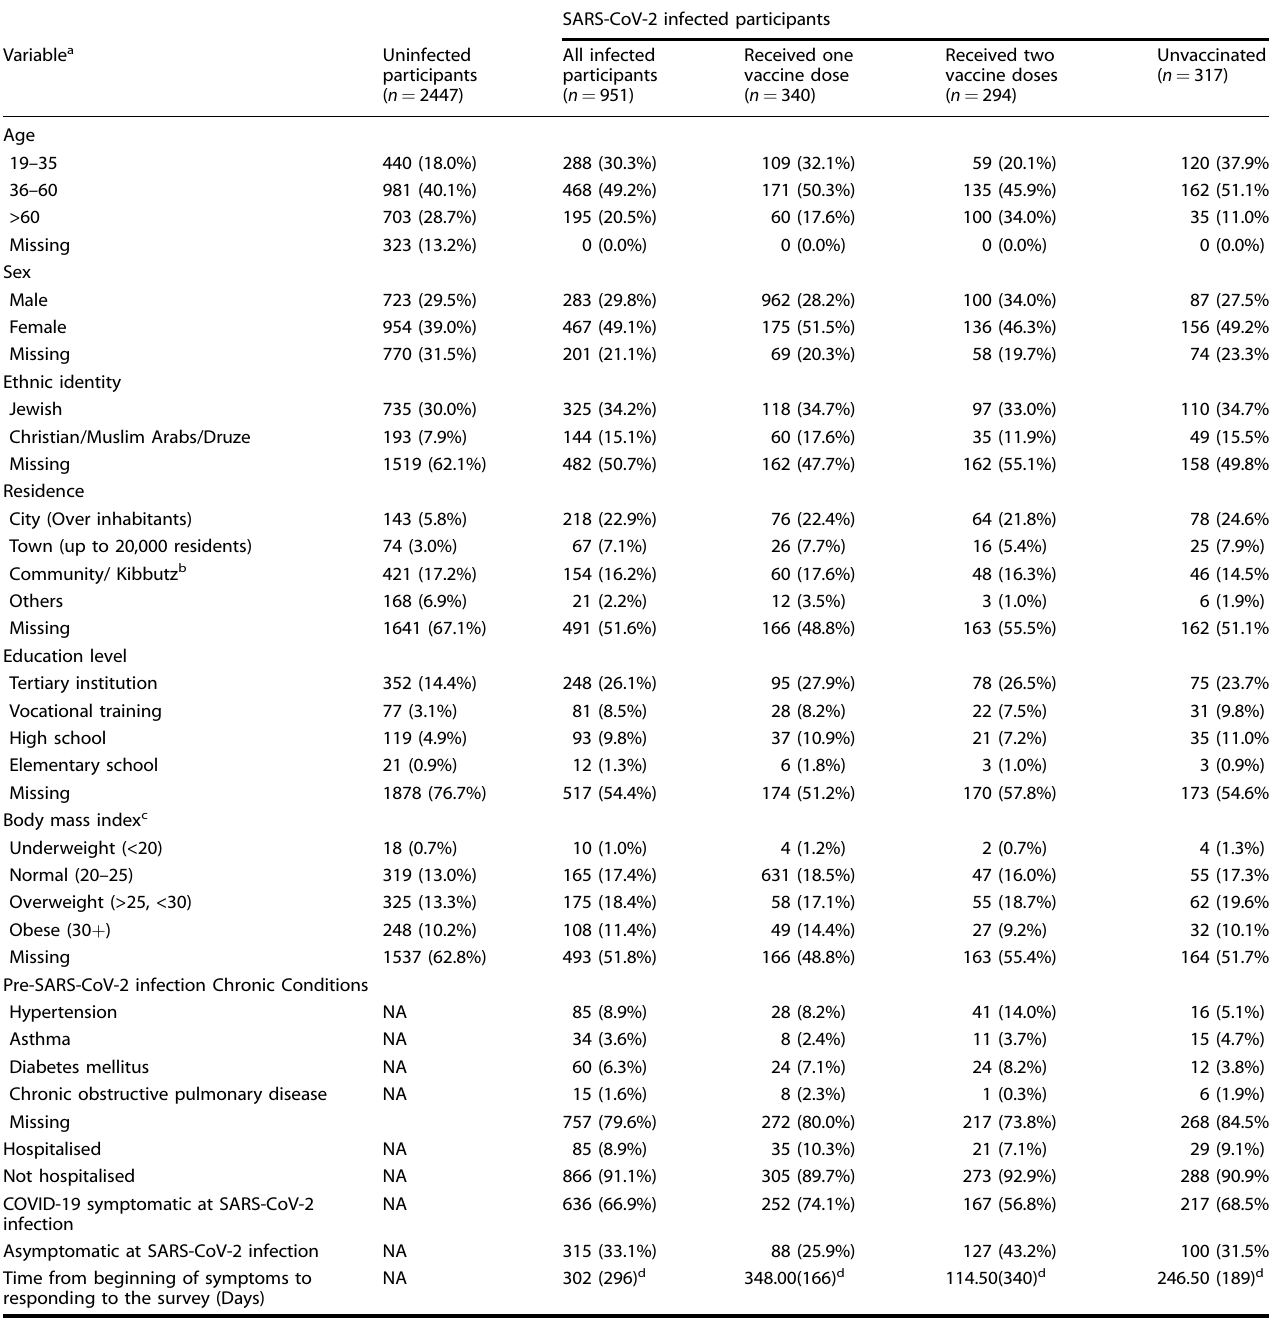
Table 1. Baseline characteristics of the study